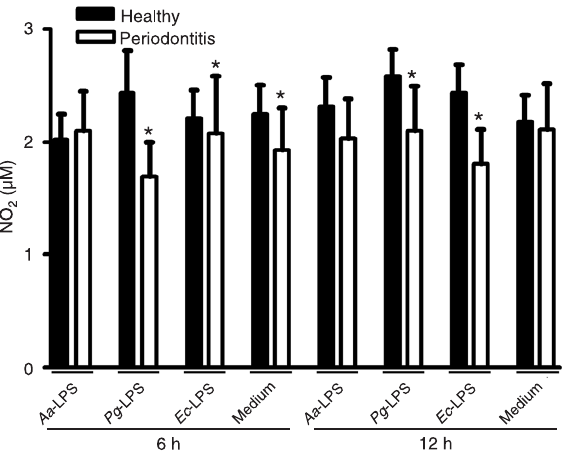
Figure 3. NO production by neutrophils stimulated with LPS. Neutrophils isolated from peripheral blood of periodontitis and healthy subjects were cultured for 6 and 12 h in the presence and absence of Aa- LPS (100 ng/mL), Pg- LPS (100 ng/mL) and Ec- LPS (100 ng/mL). Nitric oxide (NO) concentrations were mea- sured by the Griess reaction in the cell culture supernatant. Data are reported as means ± SD for N = 6 in each group. *P ≤ 0.05, periodontitis compared to healthy subjects (Student t -test). For abbreviations, see legend to Figure